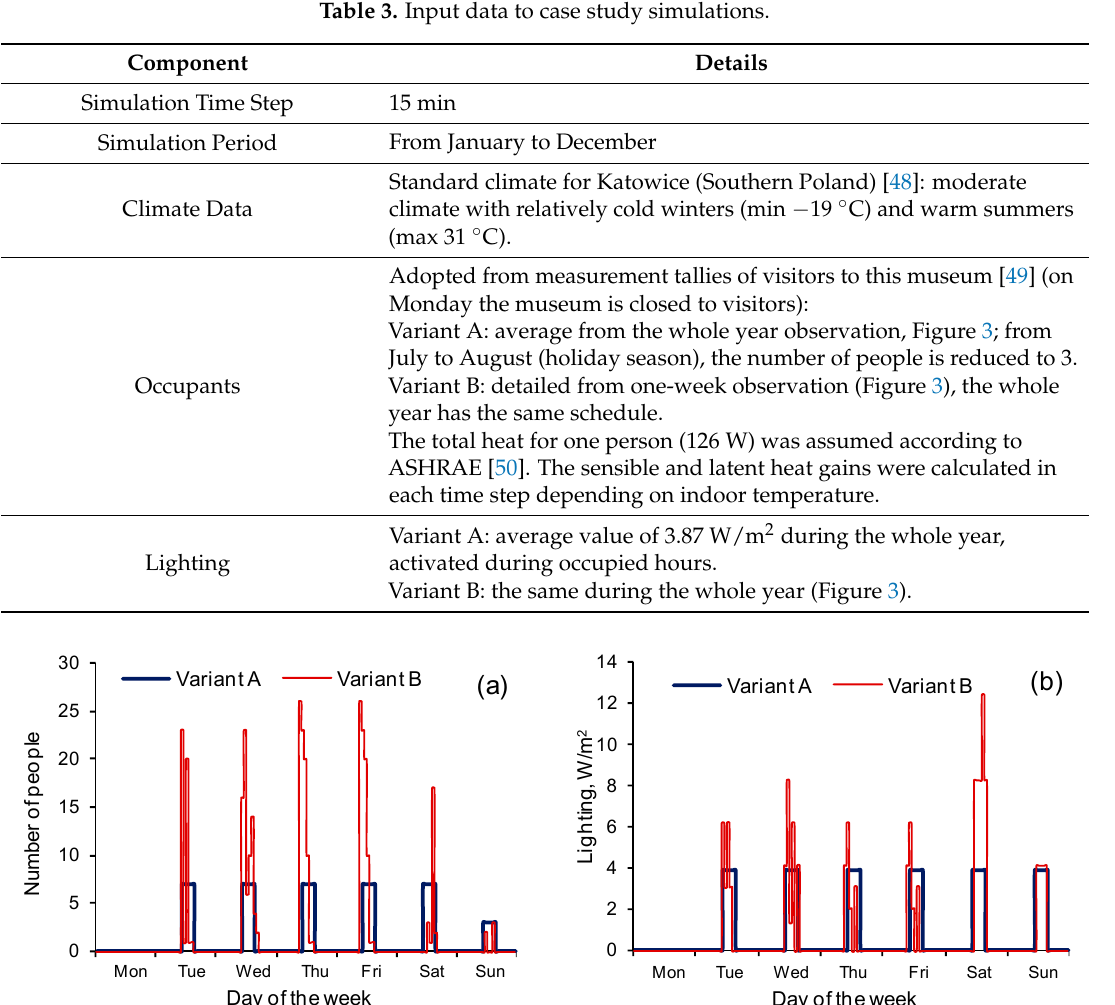
Figure 3. Schedule of occupancy ( a ) and lighting ( b ) for simulation using the A or B variants of internal heat gains.